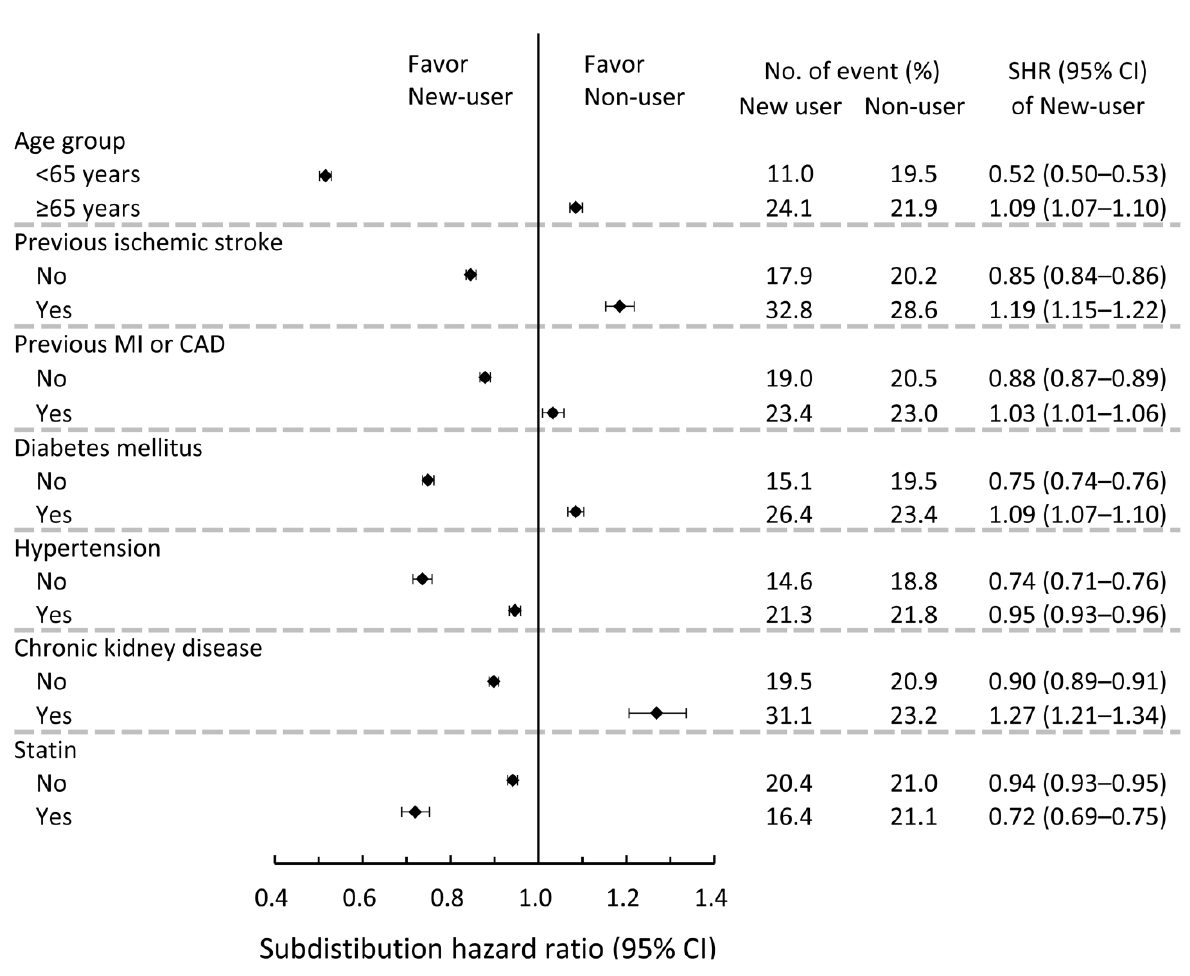
Figure 3. Pre-specified subgroup analyses comparing the risk of 2-year recurrent ischemic stroke between new colchicine users and non-users in the study cohort after IPTW. IPTW, inverse probability of treatment weights.